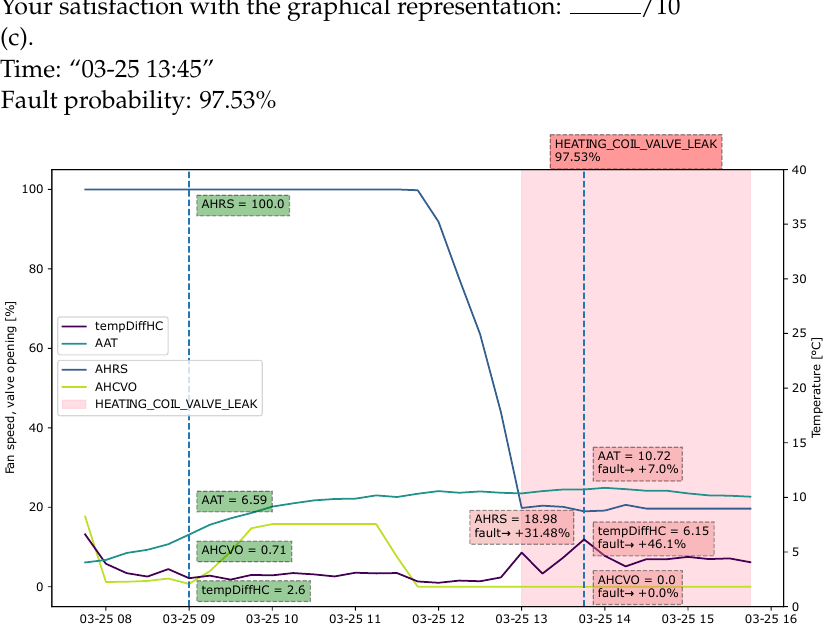
Figure A7. Heating coil valve leakage. Modified SHAP plot for sliding window explanation. Does the above plot explain fan pressure sensor malfunction? (Strongly Agree / Somewhat Agree / Neutral / Somewhat Disagree / Strongly Disagree) Your satisfaction with the graphical representation: